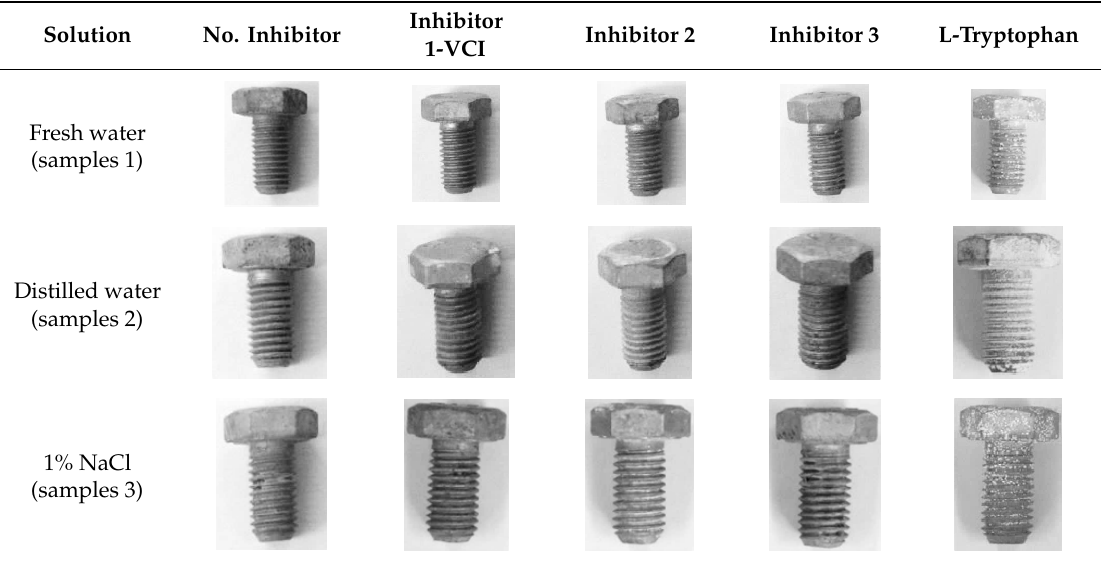
Table 1. Samples of galvanized bolts after 24 h in solutions with and without inhibitors.